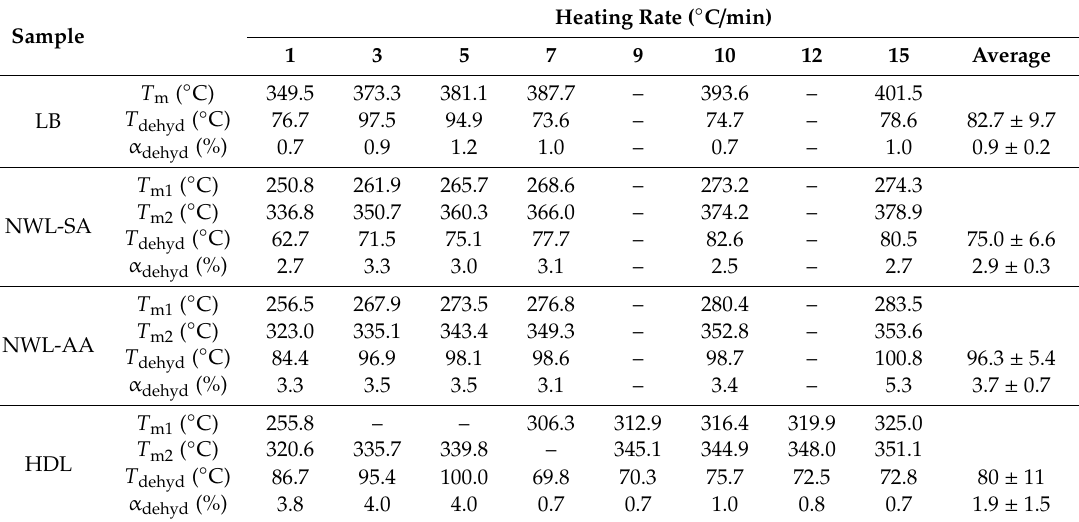
Table 4. Values of characteristic temperatures and conversions observed for the first and second peaks (numbered 1 and 2) at various heating rates.